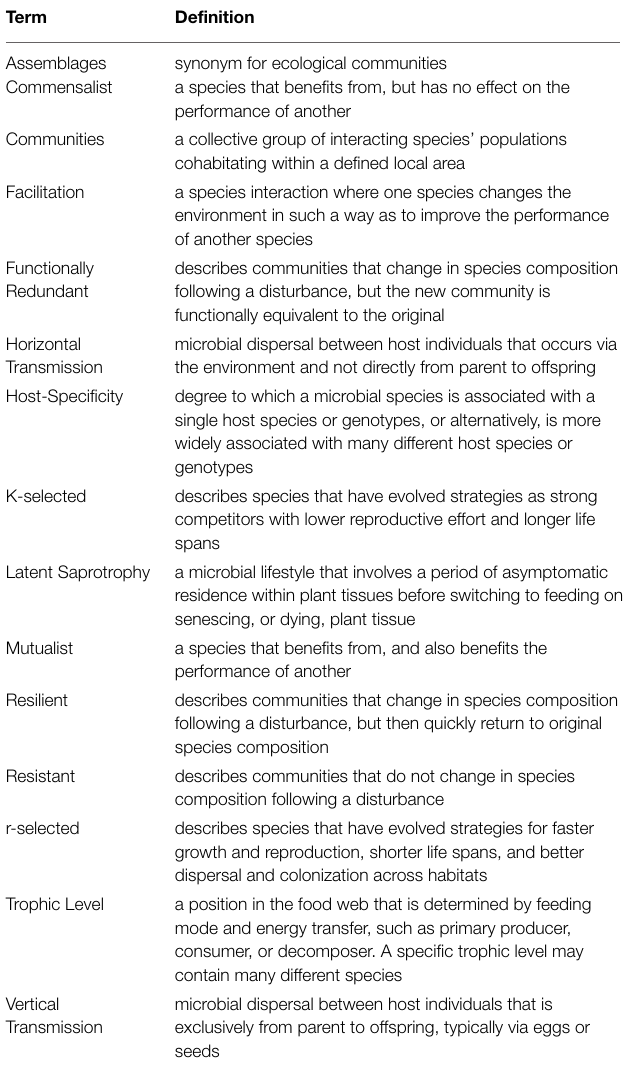
TABLE 1 | Glossary of common terms used in community